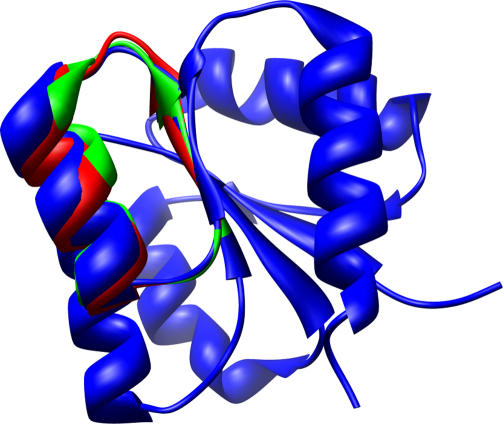
Helix Reconstruction and Prediction of FixJThe loop-helix-loop region of FixJ was predicted starting from either the phosphorylated structure (blue) or the unphosphorylated structure (unpublished results). The reconstruction (starting from the phosphorylated structure) is in red, and the prediction (starting from the unphosphorylated structure) is in green. Figure prepared with Chimera [72].